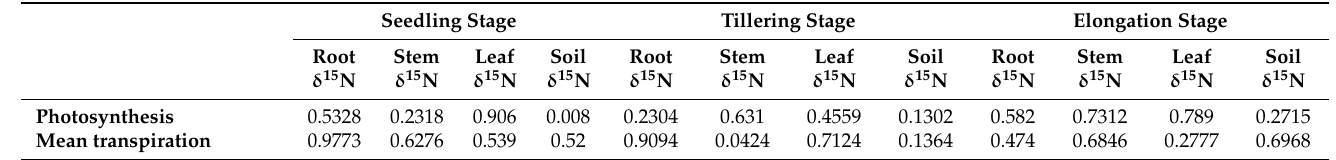
Table 6. Results of correlation analysis between soil nitrogen isotope ( δ 15 N) content in different growth stages of sugarcane and different plant and soil parameters.